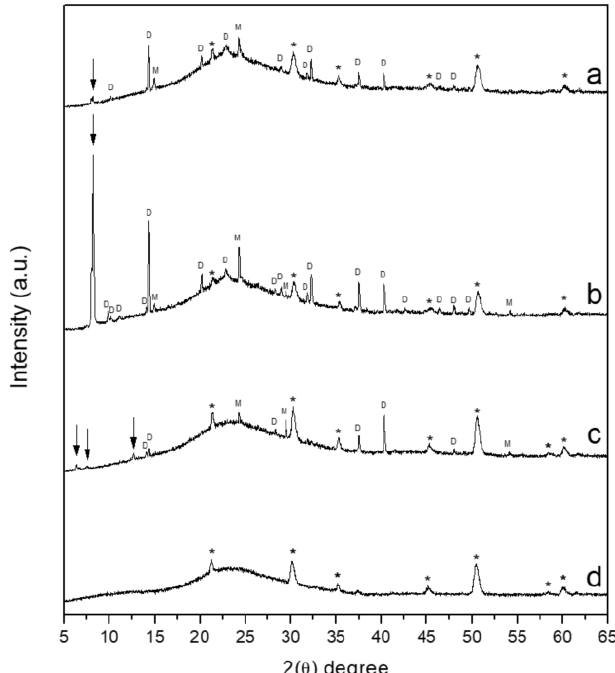
Figure 12. XRD di ff ractograms of CaOx crystals obtained on ITO substrate modified: ( a ) with R-chitosan fibers, ( b ) with A-chitosan fibers, ( c ) ITO (control, bare substrate), and ( d ) ITO glass substrate. The designations of D, M, * and ↓ correspond to COD, COM, reflections from ITO glass and the unidentified phases, respectively.